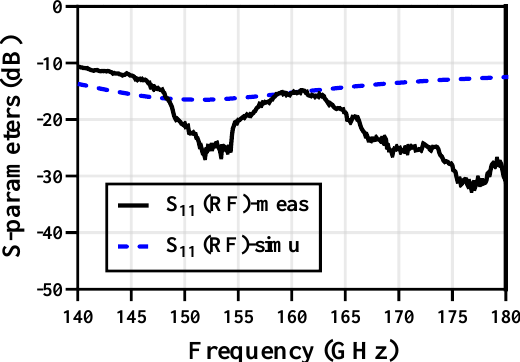
Figure 15. Simulated and measured S-parameters of the RF input.